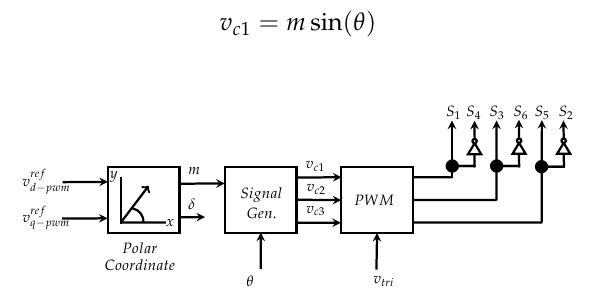
Figure 8. PWM generation scheme using polar